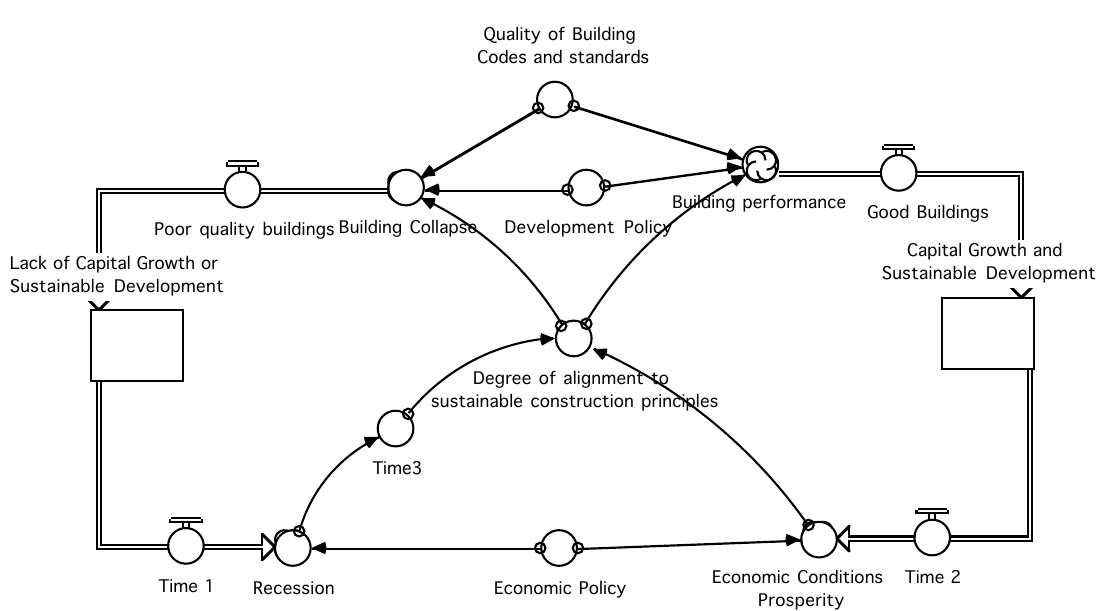
Figure 2. Causal loop diagram of the study using iThink 9.1.4 Trial ©